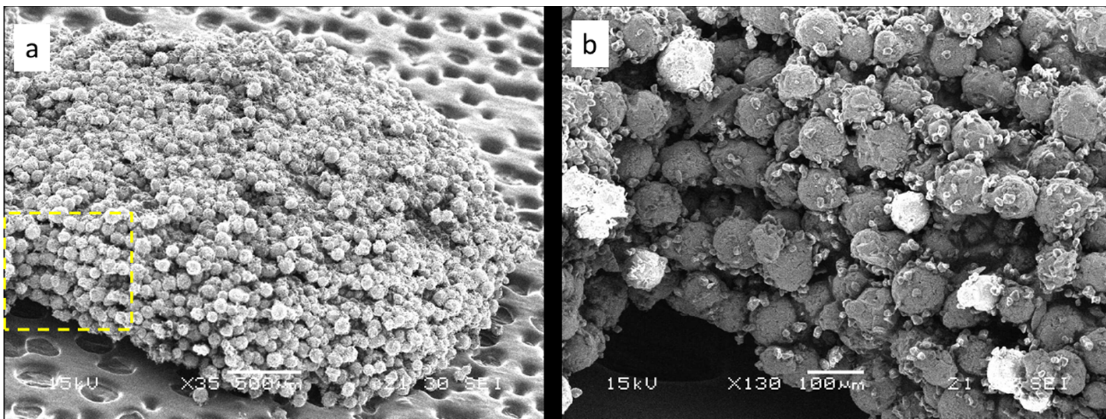
Figure 4. SEM image of Fe 3 O 4 microspherical particles array of the FC sample after application of rotating magnetic field method ( a ) and the surface of Fe 3 O 4 particles at 40,000x magnification ( b ).